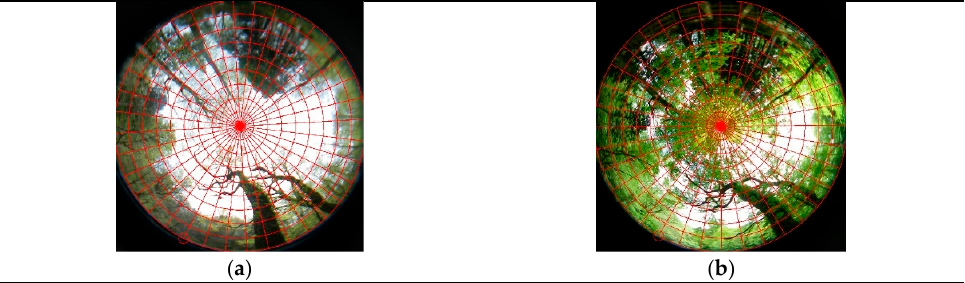
Figure 14. Images of the sky above Ao-ike Pond taken with the fisheye lens. The grid is cut in 10°